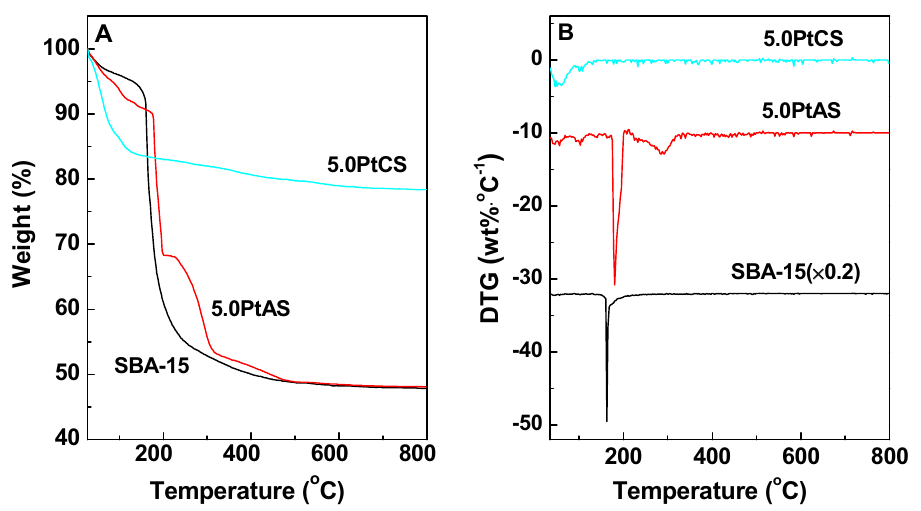
Figure 6. ( A ) TG and ( B ) DTG curves of SBA-15, 5.0PtAS and 5.0PtCS samples before calcination. DTG curves are plotted offset for